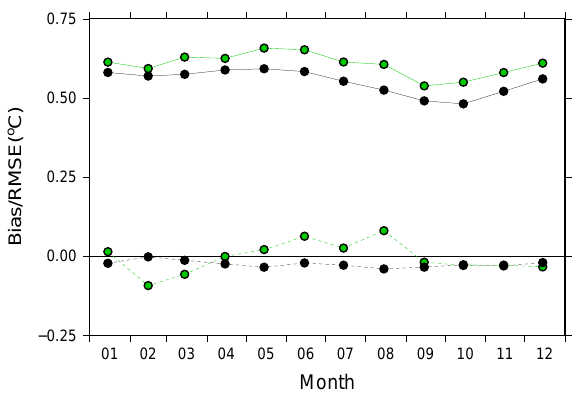
Figure 10. Seasonal validation statistics of the daily-mean SST (green: New Generation SST for Open Ocean (NGSST-O) Version 1.6) and foundation SST (black: this study) products in the western North Pacific (13–63 ◦ N, 113–163 ◦ E) during 2003–2011. Calculated RMSE and bias are shown by solid and dashed lines,